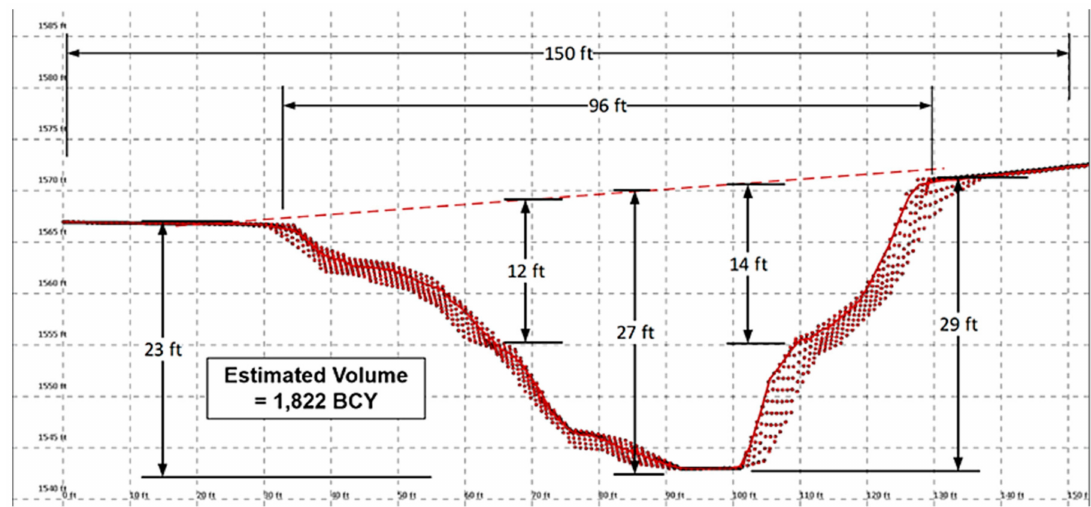
Figure 4. Example of LiDAR-based cross-section with measurements of the PR-770 washout near Barranquitas, Puerto